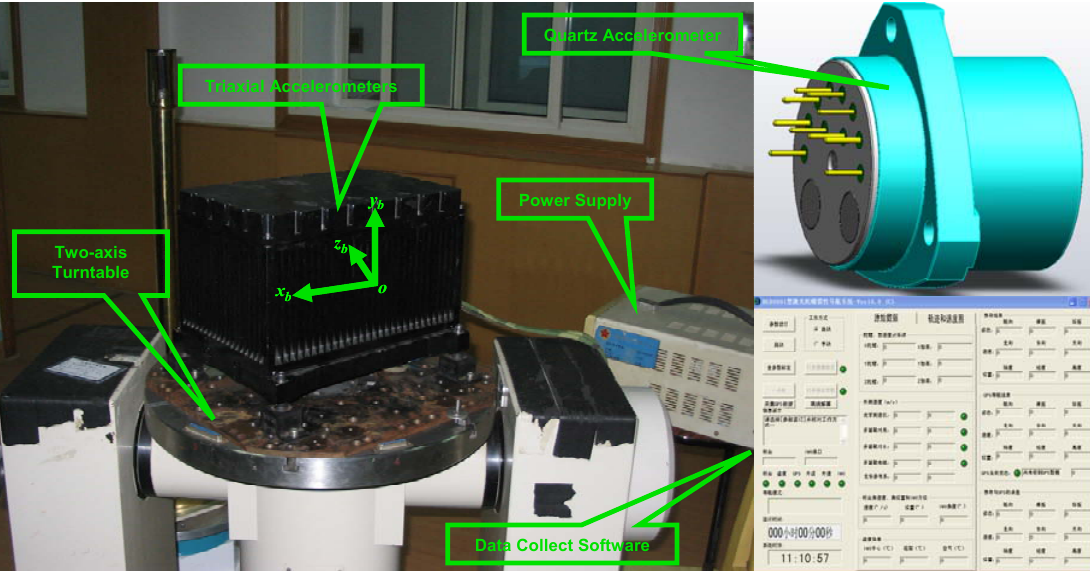
Figure 4. The experimental conditions for the calibration of triaxial accelerometers.